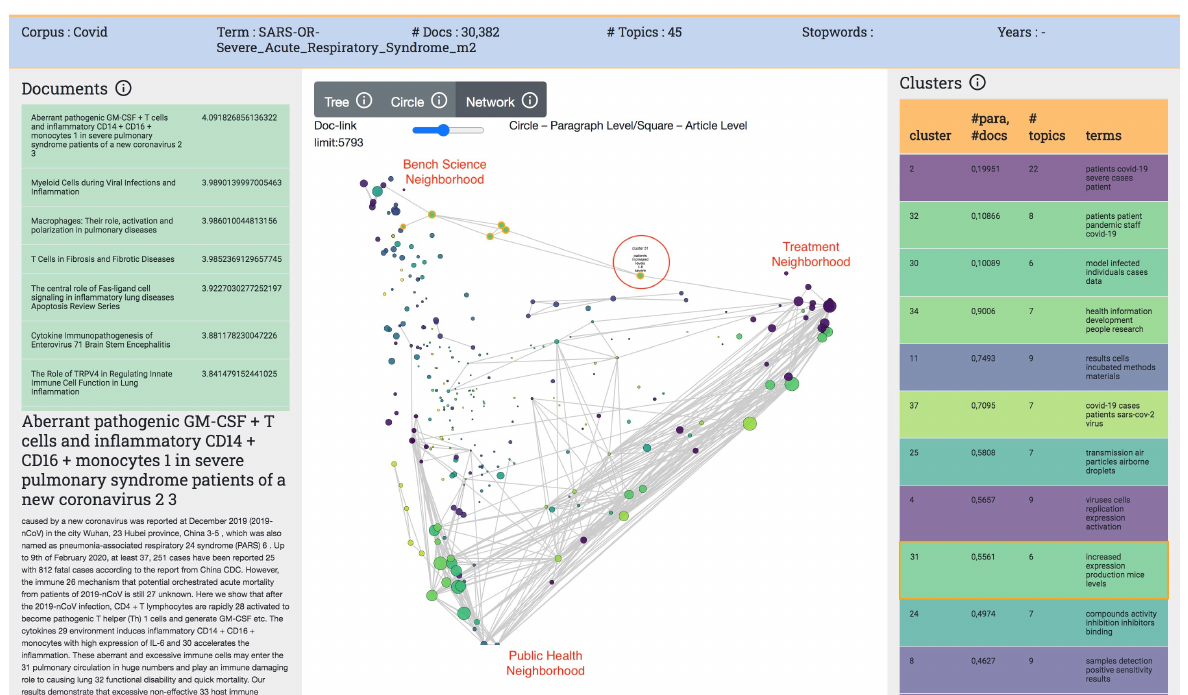
Figure 2. Network visualization of the SARS Topic